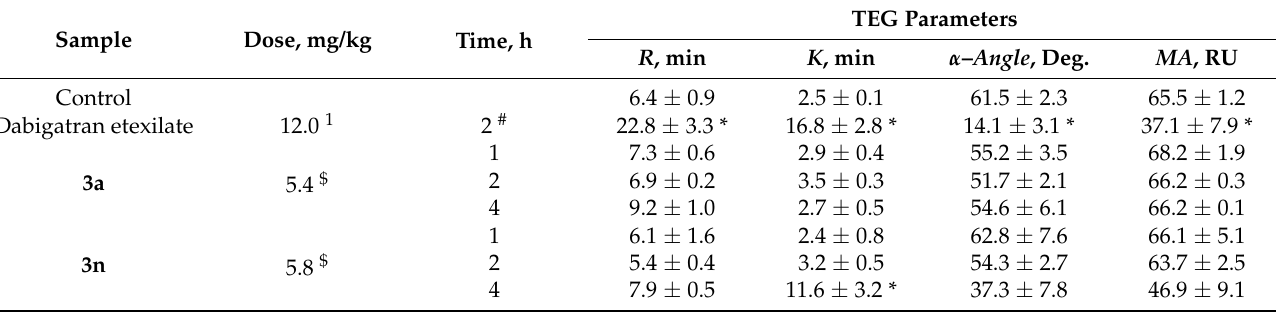
Table 7. Effect of compounds 3a and 3n on thromboelastogram (TEG) of rats with a single intragastric administration (M ± m, n =